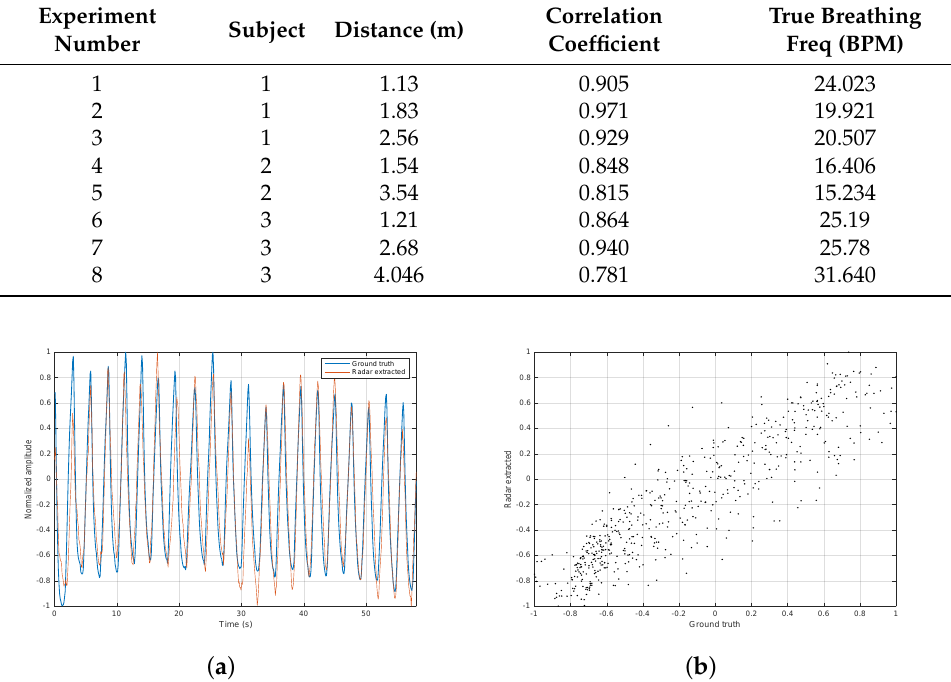
Figure 7. Experiment 1 signal extraction. ( a ) ground truth and radar extracted on top of each other. ( b ) correlation